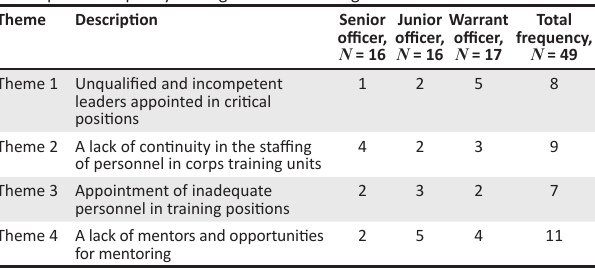
TABLE 2: Perceptions of officers regarding the role of leaders’ career development in quality management of